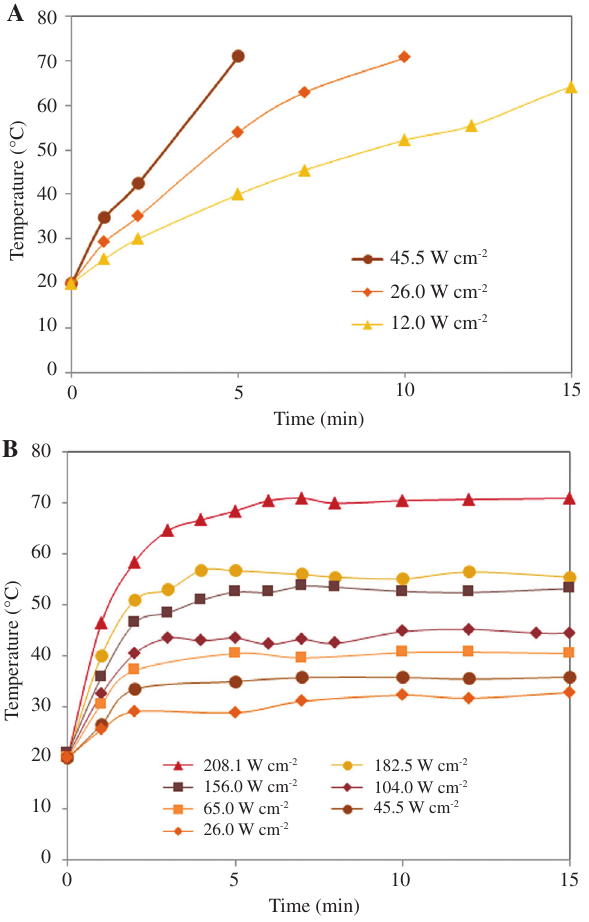
Figure 2 Temperature profiles of bulk reaction mixtures during mmim][Br] at various ultrasonic intensities stated in synthesis of [C 7 legends: (A) without external cooling and (B) with external cooling by means of a water bath set to 20 ° C. Initial conditions: 0.1 mol of 1,2-dimethylimidazole and 0.11 mol of 1-bromoheptane.